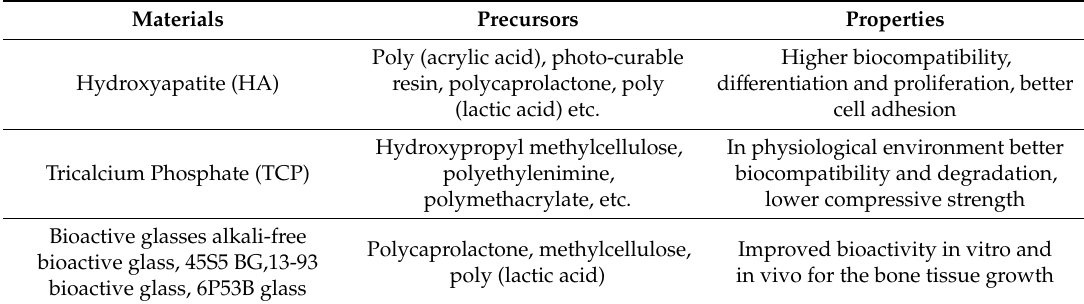
Table 2. A brief review of ceramic materials and its properties used in 3D printing of Sca ff olds.